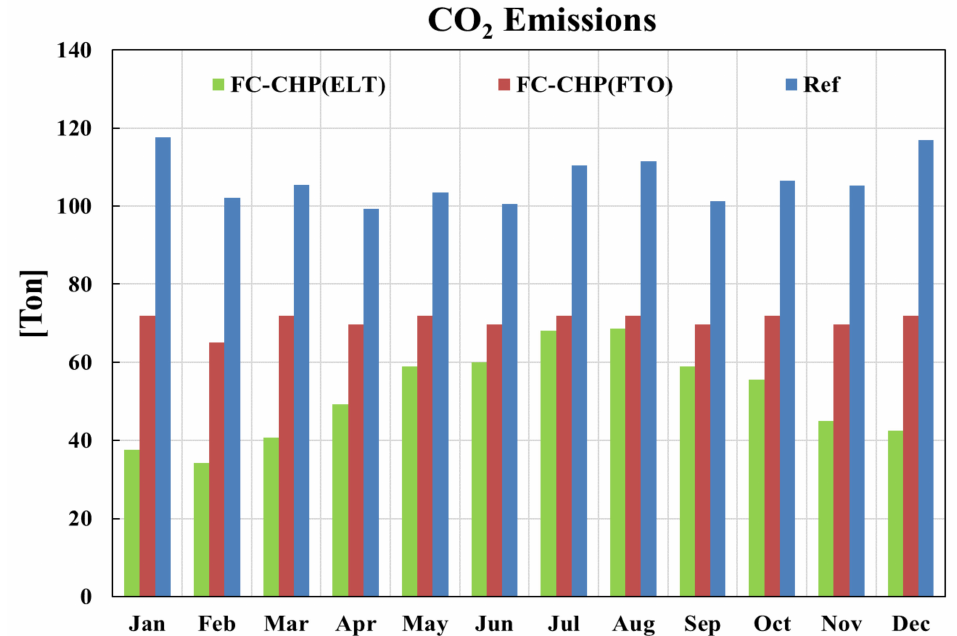
Figure 12. CO 2 emissions for the three case studies (ELT and FTO models in FC-CHP systems and the conventional energy supply